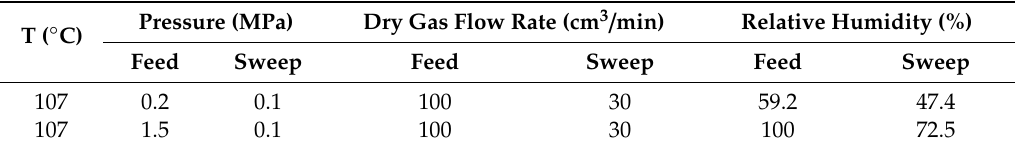
Table 1. Operating conditions for gas transport performance